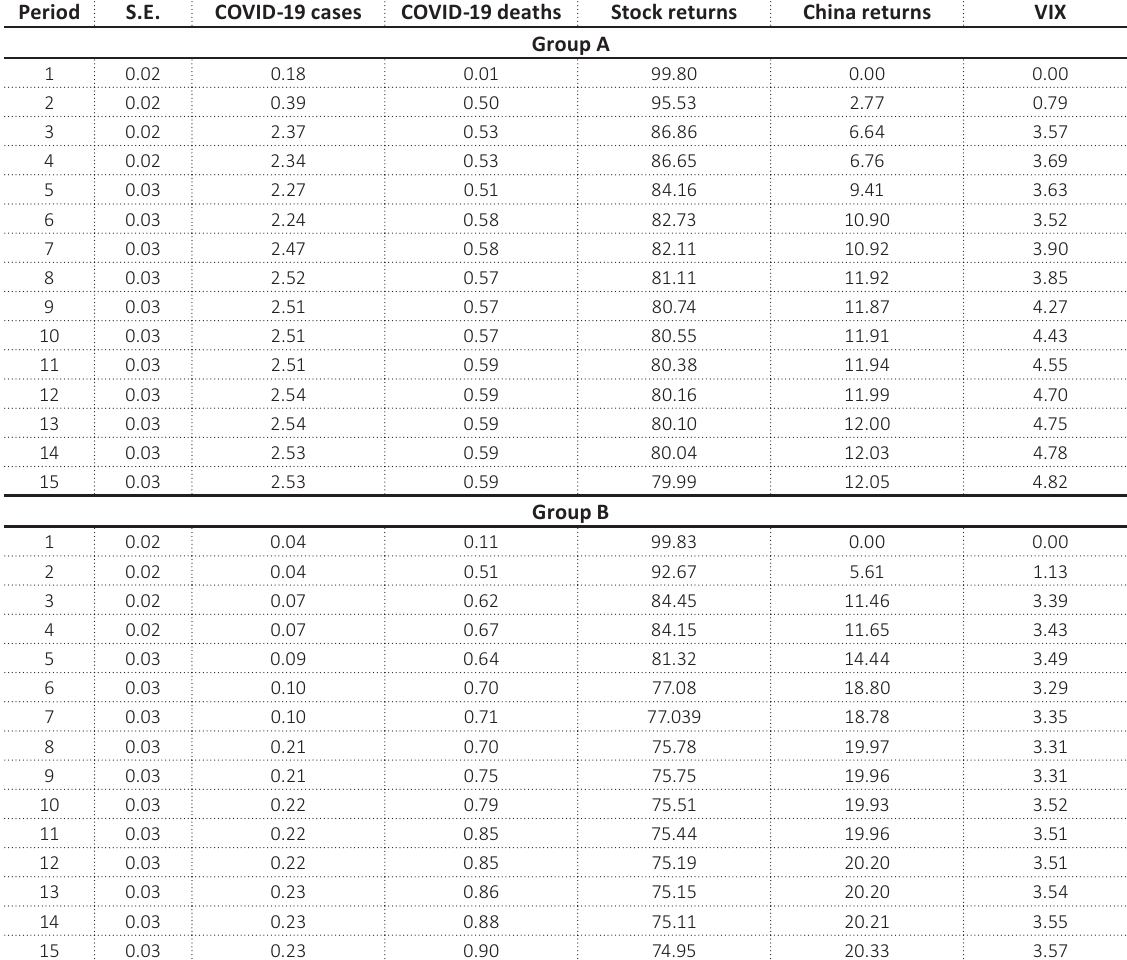
Table 3. Contribution of Chinese returns, COVID-19 deaths and cases, and VIX to the forecast error variance of European stock returns per group